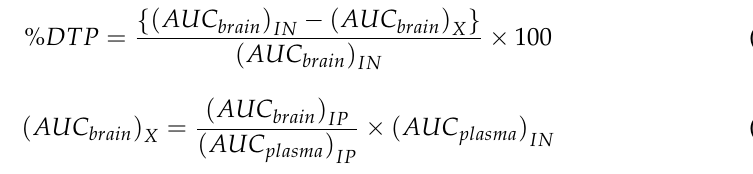
Table 1. Pharmacokinetic parameters of ANA-TA9.